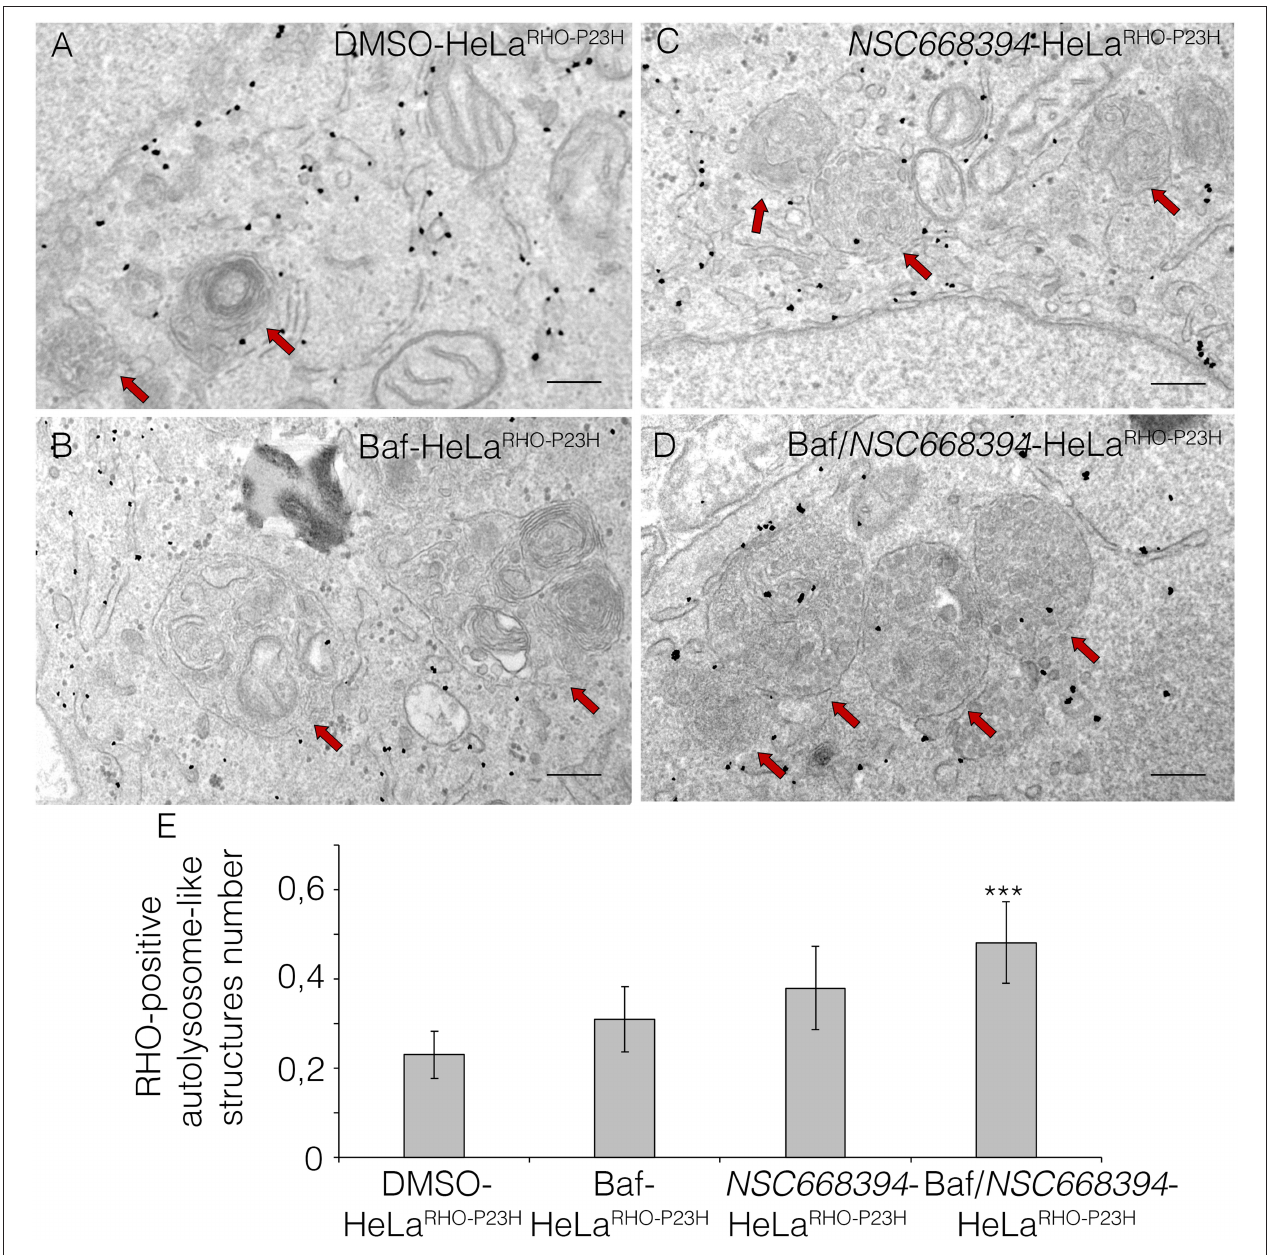
FIGURE 5 | Ezrin inhibition induces RHO disposal via lysosomal activity. Immuno-electron microscopy (IEM) analysis of HeLa RHO − P23H cells treated with DMSO (A) , Baf (B) , NSC668394 (C) , and Baf/ NSC668394 (D) . Scale bar 250nm. The RHO-positive autolysosome-like structures are indicated with red arrows. (E) The blot shows the quantification of the number of RHO-positive autolysosome-like structures. Bar graphs represent mean values ± SEM of independent experiments. *** p ≤ 0.005 t -test (Baf/ NSC66834 -HeLa RHO − P23H vs. DMSO-HeLa RHO − P23H ).